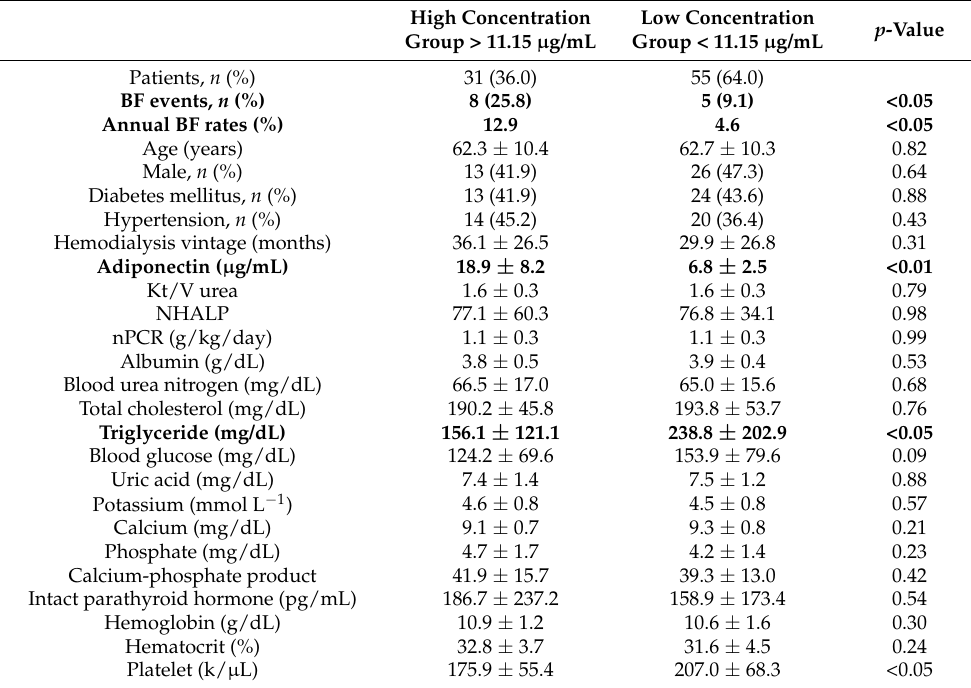
Table 2. Comparison of BF events and bio-clinical parameters between higher and lower concentra- tion groups according to the mean value of